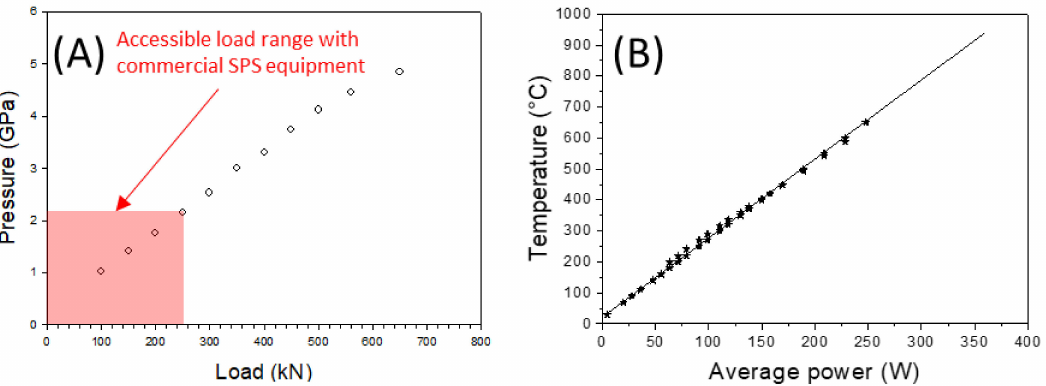
Figure 6. Calibrations of the Paris–Edinburgh HP-SPS cell: ( A ) Calibration curve of the pressure performed from in situ neutron diffraction of a NaCl sample using its equation of state. The orange area indicates the pressure range accessible with the Paris–Edinburgh module mounted on standard SPS equipment (maximum load 250 kN) ( B ) Calibration curve of the temperature, as a function of the average power of the pulsed current, performed by placing a K-type thermocouple in the center of an alumina